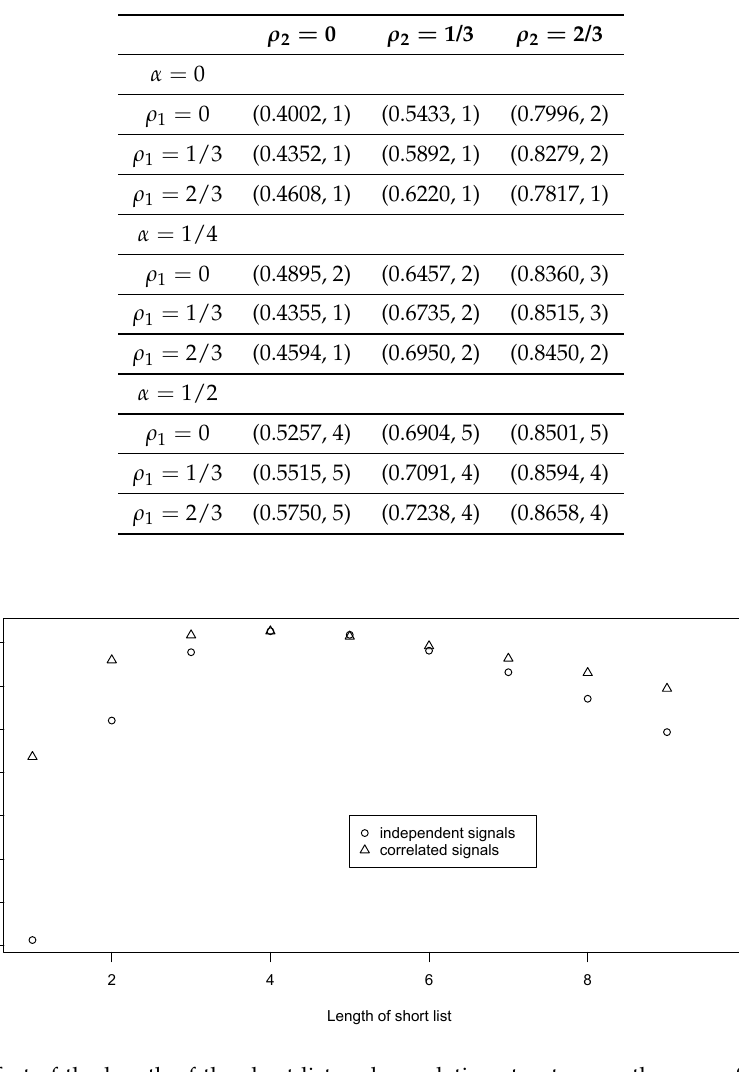
Figure 2. Effect of the length of the short list and correlation structure on the sum of the rewards obtained when r = σ 1 = σ 2 = 1. The correlated signals plot corresponds to ρ 1 = ρ 2 = 2/3 and the payoffs are scaled so that the maximum of the sum of the expected rewards are equal. This graph indicates that the efficiency of the game-theoretic procedure is much more sensitive to the good will between the DMs when their preferences are independent than when they are